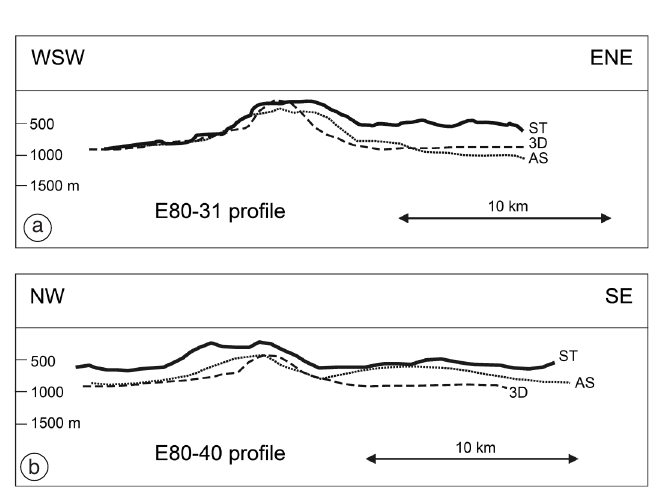
Fig. 12a,b. 2D comparison between seismic derived topography (ST), Analytic Signal (AS) and Fedi (1997) 3D inversion (3D) along the a) E80-31 and b) E80-40 seismic lines of figs. 3 and 4 located in fig.